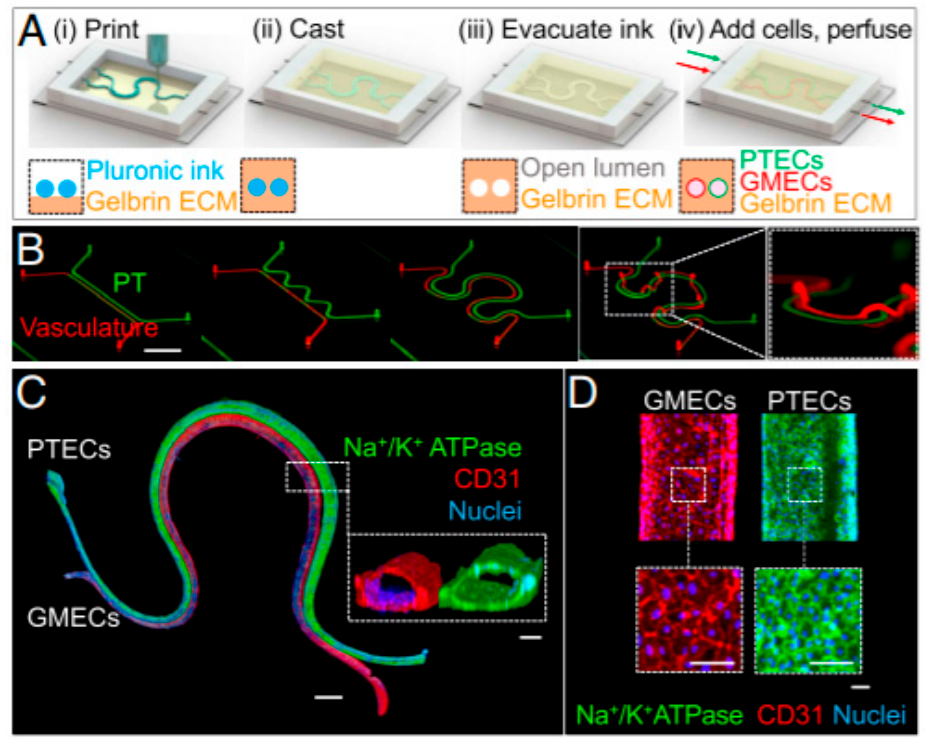
Figure 7. Schematic illustration of the fabrication of a vascularized 3D bioprinted model ( A ). Different design patterns ranging from straight to serpentine (Scale bar is 10 mm) ( B ). Immunostaining of 3D final VasPT model (Scale bar is 1 mm) and cross-section (inset) of the PT and vascular conduits (scale bars are 100 µ m) ( C ). High magnification of the two lumens (scale bars are 100 µ m) ( D ). From Reference [107], with permission from Proceedings of the National Academy of Sciences of the United States of America (PNAS).